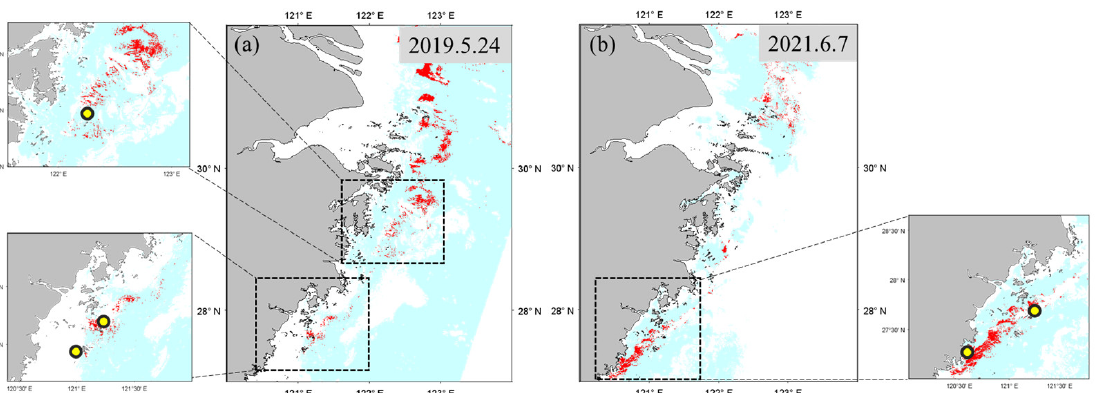
Figure 8. Bloom waters of ( a ) 24 May 2019 and ( b ) 7 June 2021 extracted using the adjusted SS(490) method. The areas indicated by the rectangular polygon and the highlighted circles are the main bloom occurrence locations provided by bloom reports from the China Marine Disaster Bulletin.